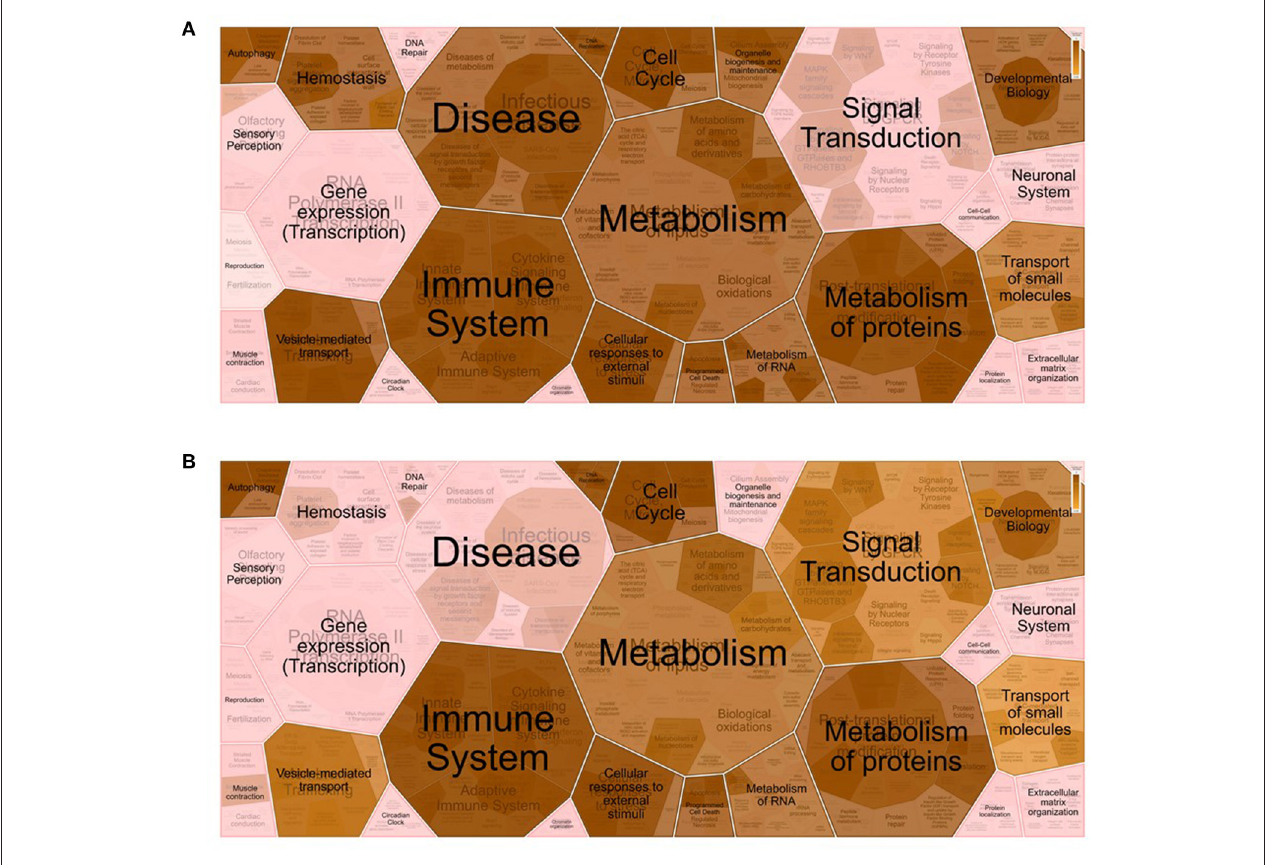
FIGURE 2 | Voronoi pathway visualization (Reacfoam) for the identified proteins from equine oviductal fluid belonging to the Gene Ontology (GO) categories extracellular exosome (GO:0070062) (A) and cytoplasm (GO:0005737) (B) . A Reactome overrepresentation pathway analysis of the identified proteins listed in the above-mentioned GO categories (see Supplementary Table 2 ) was performed with the analysis tool of Reactome (https://reactome.org/) by exploring the corresponding gene names in the Homo sapiens database. The p -values are shown with the gradient from pink ( p > 0.05) through light brown (0.05 < p < 0) to dark brown ( p ≈